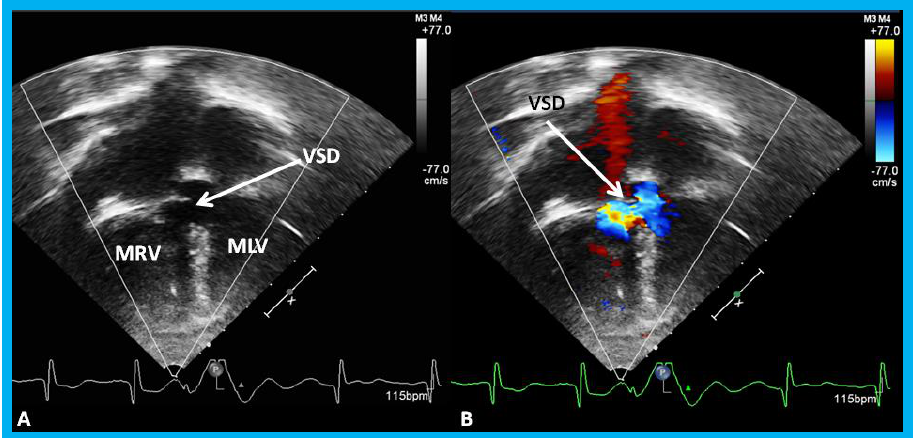
Figure 18. Selected video frames by two-dimensional ( A ) and with color flow imaging ( B ) from apical four-chamber view from the right chest demonstrating morphologic right (MRV) and morphologic left (MLV) ventricles and a large VSD (ventricular septal defect) in a patient with dextrocardia. Reproduced from Yarrabolu T.R., et al. [23].